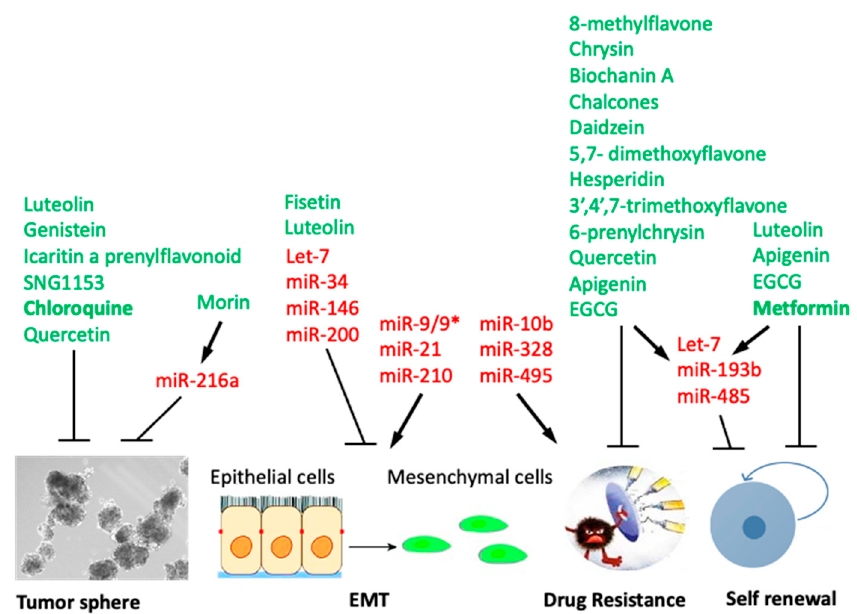
Figure 3. Graphical summary of flavonoids targeting major hallmarks of the CSC phenotype, including those regulated by microRNAs. Flavonoid names are in green; microRNAs are in red.